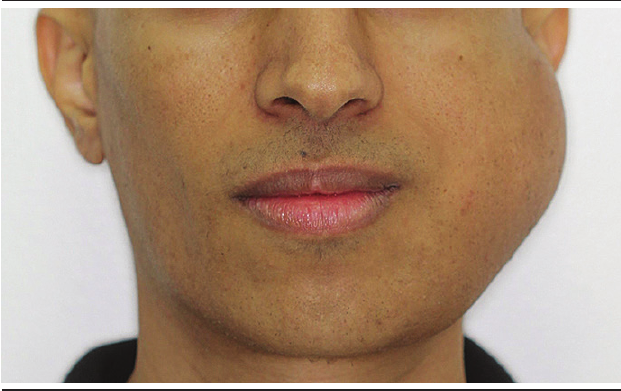
FigurE 4 − Frontal image of the patient, showing volume increase in the middle and lower third of the face, left side, with no cardinal